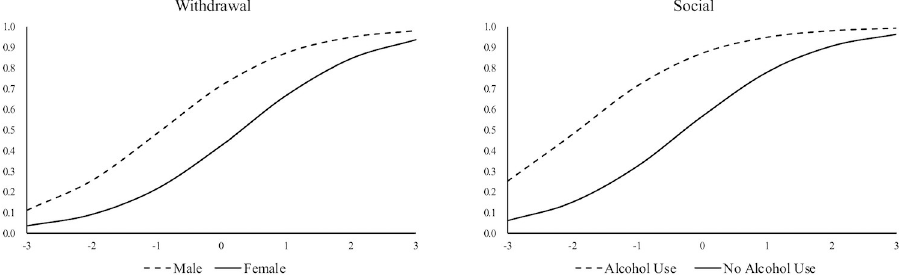
Fig 2. ICC plots of two example DIF symptoms. The left panel presents the ICC of “withdrawal”, and the right panel presents the ICC of “social”.